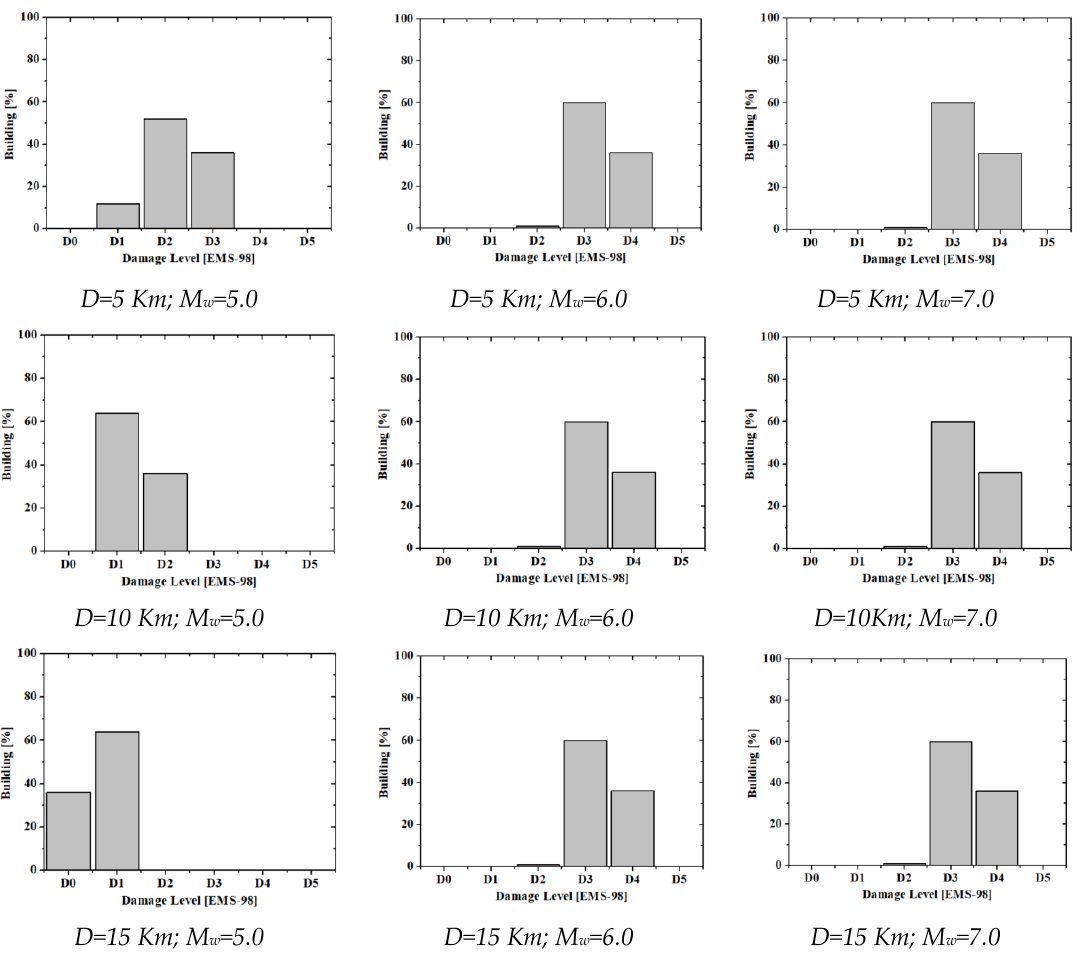
Figure 11. Damage distribution for different epicentre distance and moment magnitude combinations.